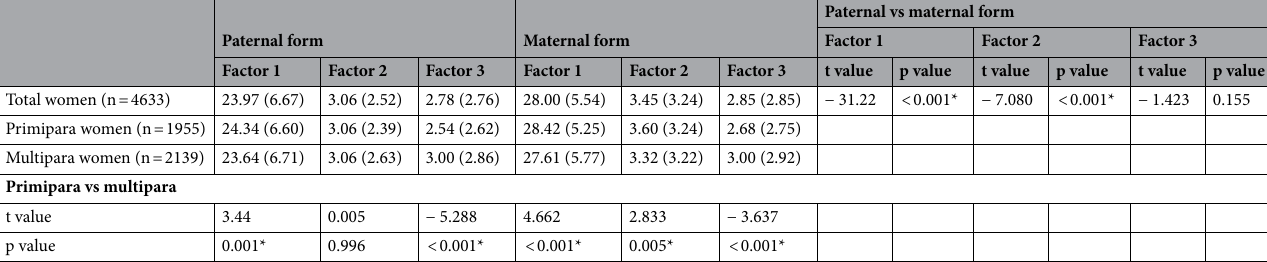
Table 5. Comparison of the mean value of each factor between the paternal and maternal forms, and between primipara and multipara women. *The level of significance was set at p < 0.006 according to the Bonferroni correction of nine statistical